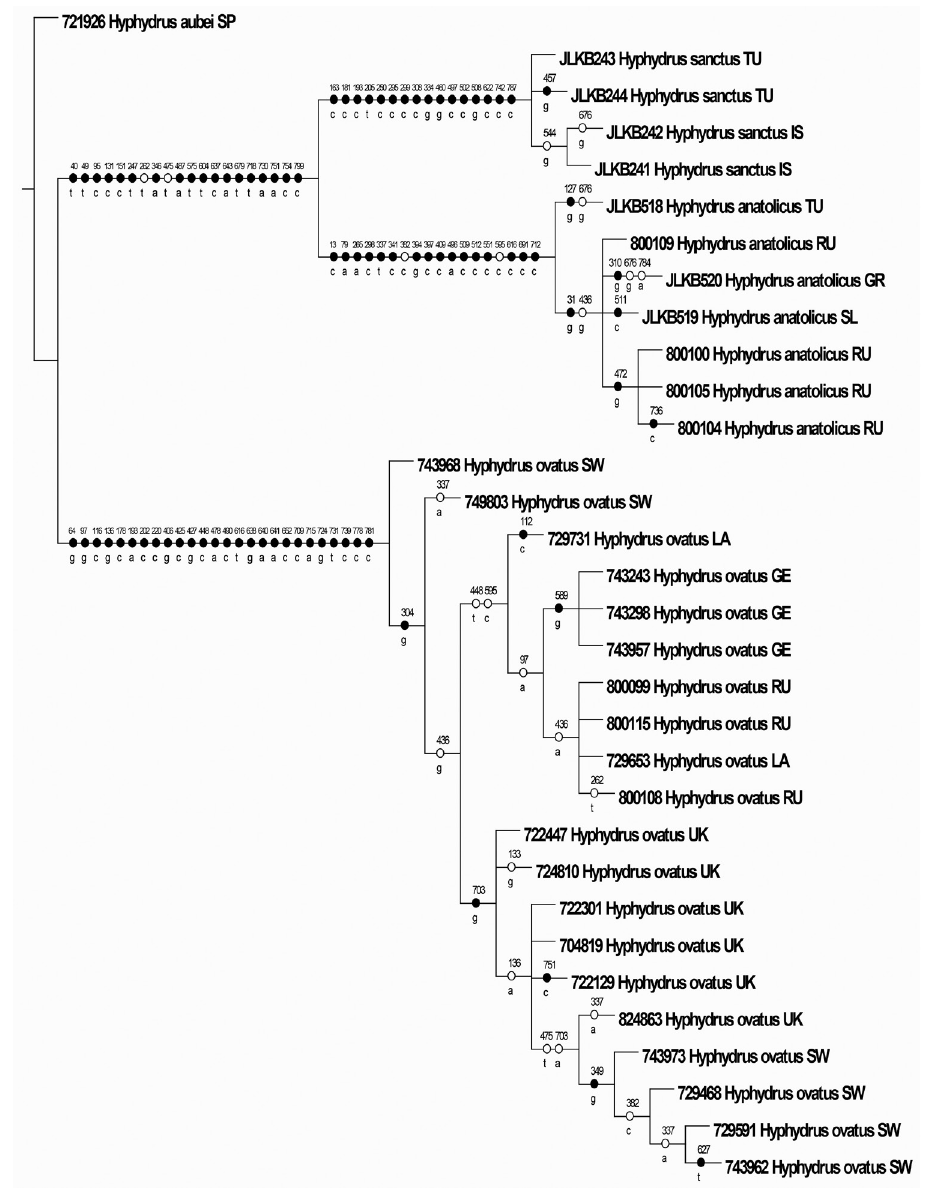
Figure 2. One of 14 most parsimonious trees (L=203, zero-length branches hard-collapsed) with unam- biguous characters optimized. Black dots=non-homoplasious characters, white dots=homoplasious charac- ters. Numbers refer to the character’s position in the alignment from 1-825. The other 13 cladograms only differed in within-species internal organizations. Rooted with Hyphydrus aubei . Country abbreviations as in Figure